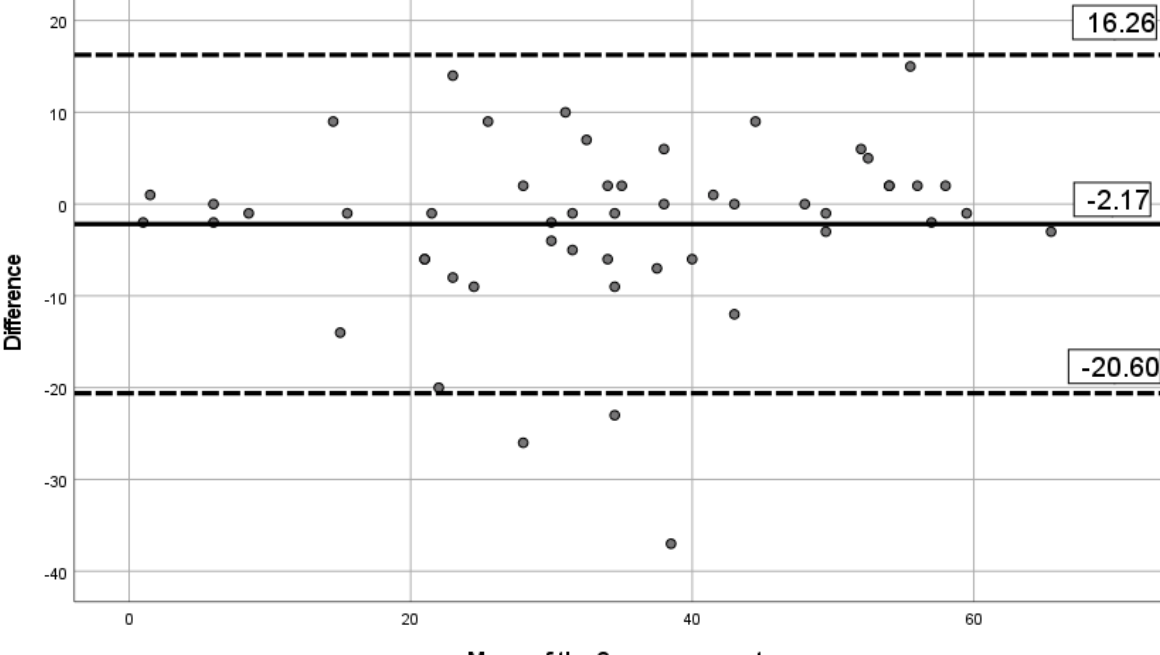
Figure 8. Bland-Altman limits for the Brief Pain Inventory pain interference subscale using the paper questionnaire and the mobile